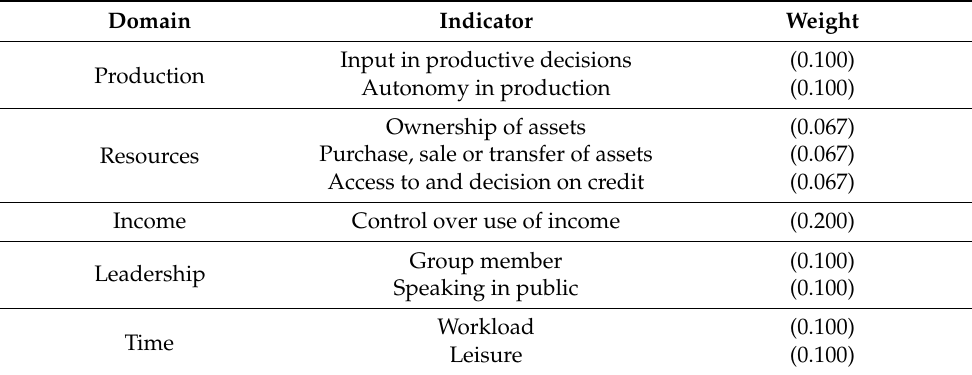
Table 1. Five domains of empowerment and their corresponding weights. Domain